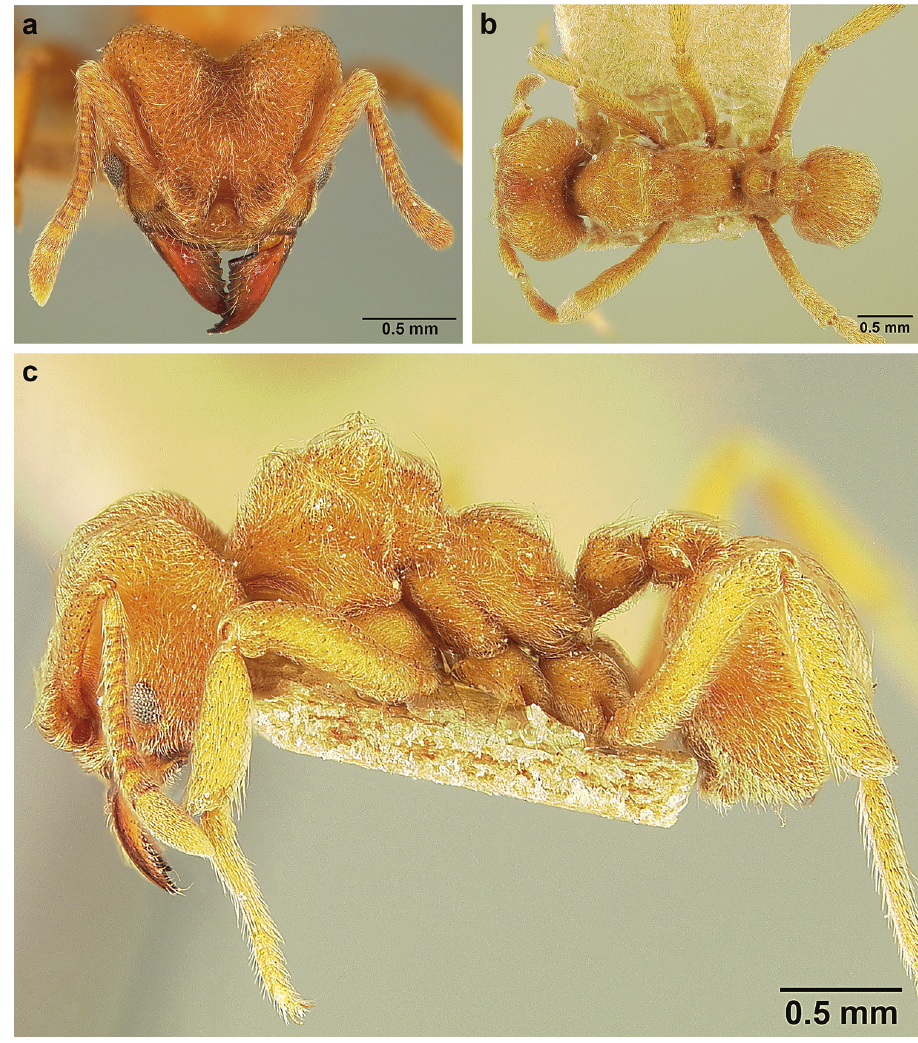
Figure 28. S. lutzi worker (MCZ 12-14 21139). a Head b dorsal view; and c lateral profile. Metasoma. Petiole and postpetiole each with two low, short, serrate carina dor- sally, on petiole sometimes reduced to low denticles, best seen in dorsolateral view. First gastral tergite with lateral carinae weakly developed, dorsal carinae absent. S. lutzi queen description. Measurements in mm: HWe 1.4 HW 1.4 HW1 1.32 HW2 1.52 HW3 IFW1 0.9 IFW2 0.34 HL1 1.36 HL2 1.16 SL 0.92 EL 0.25 Om 18 EW 0.1 WL 2.08 PL 0.44 PPL 0.28 GL 1.72 HFL 1.56 PW 1.18 1 FWg 6.82 HWg 4.6 CI 103 FLI 64 SI 66 OI 18 [N=1] Head. Mandibles with nine teeth, dorsally glossy and smooth, finely transversely striate only along masticatory margin. Preocular carina fading posterior to eye.